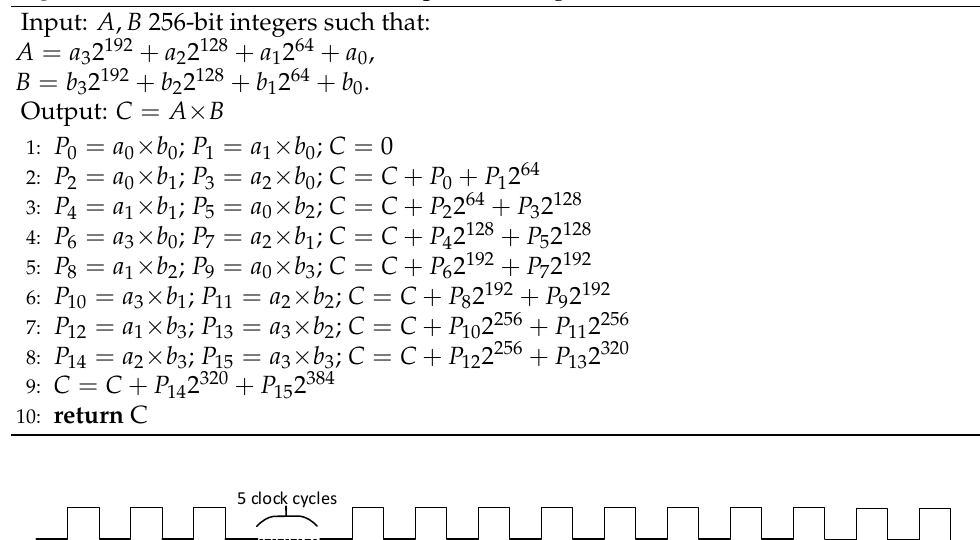
Figure 3. Proposed Hardware Architecture for the 256-bit Multiplier. Algorithm 8 Schoolbook-Based Multiplication Algorithm.